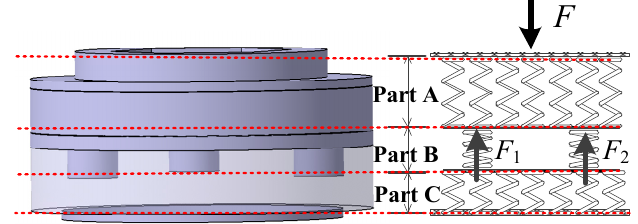
Figure 8. The equivalent spring model of the sensor.